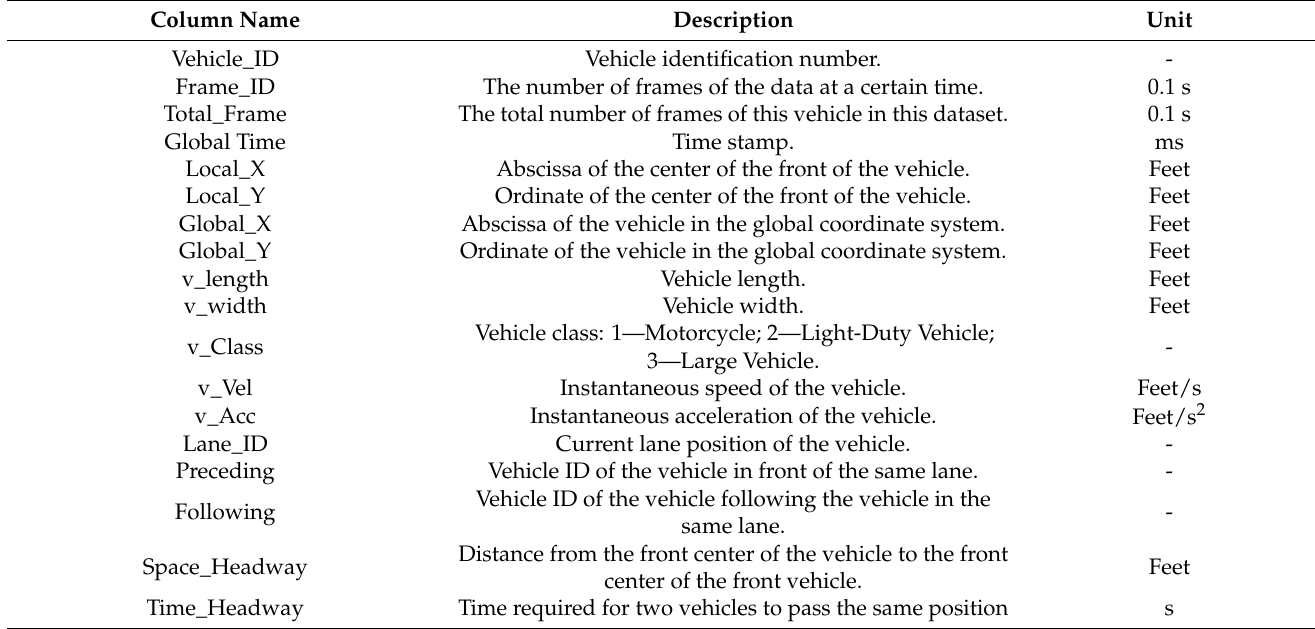
Table 1. Ngsim field data